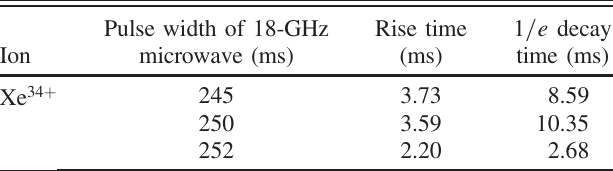
TABLE II. Detailed waveform parameters of Xe 34 þ afterglow